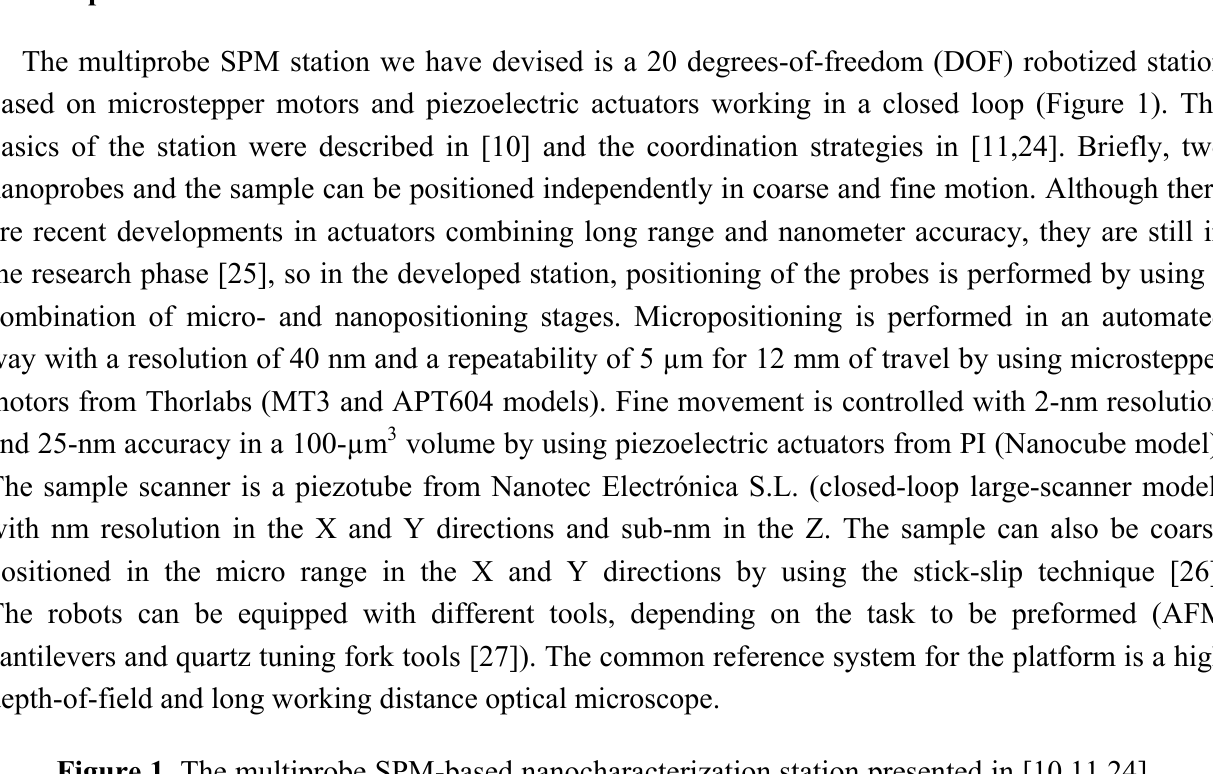
Figure 1. The multiprobe SPM-based nanocharacterization station presented in [10,11,24]. ( a ) Scheme of the different micro and nanopositioning stages. ( b ) Photograph of the developed station with a quartz tuning fork probe and an AFM cantilever as nanotools (optical microscope